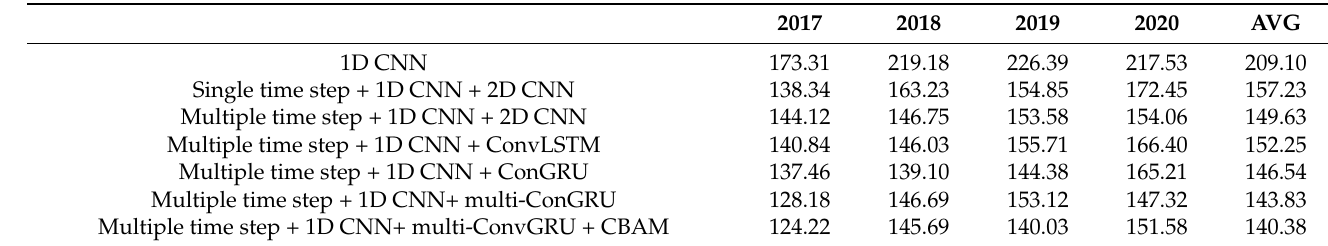
Table 7. Twenty-four hour distance error of four isobaric surfaces forecast